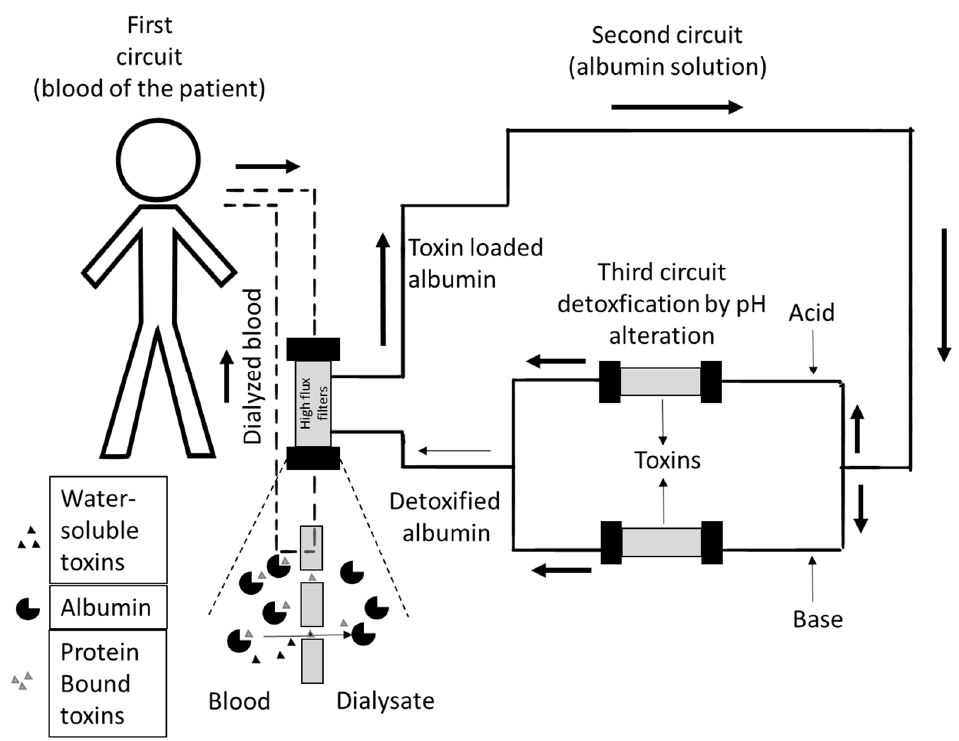
Figure 2. Schematic presentation of ADVanced Organ Support (ADVOS). In the first circuit, blood passes through a high flux filter that filters protein ‐ bound and water ‐ soluble toxins. In the second circuit, the toxin loaded albumin, together with water ‐ soluble toxins, travel to the third circuit, where albumin is recycled by pH alteration. Base and acid are added, inducing a conformational change of albumin that consequently releases the toxins. Water ‐ soluble toxins and released toxins are filtered out. When the acidified and basified albumin solution reunite, physiological pH is re ‐ established and albumin regains its previous conformation, thus being recycled for the next cycle.